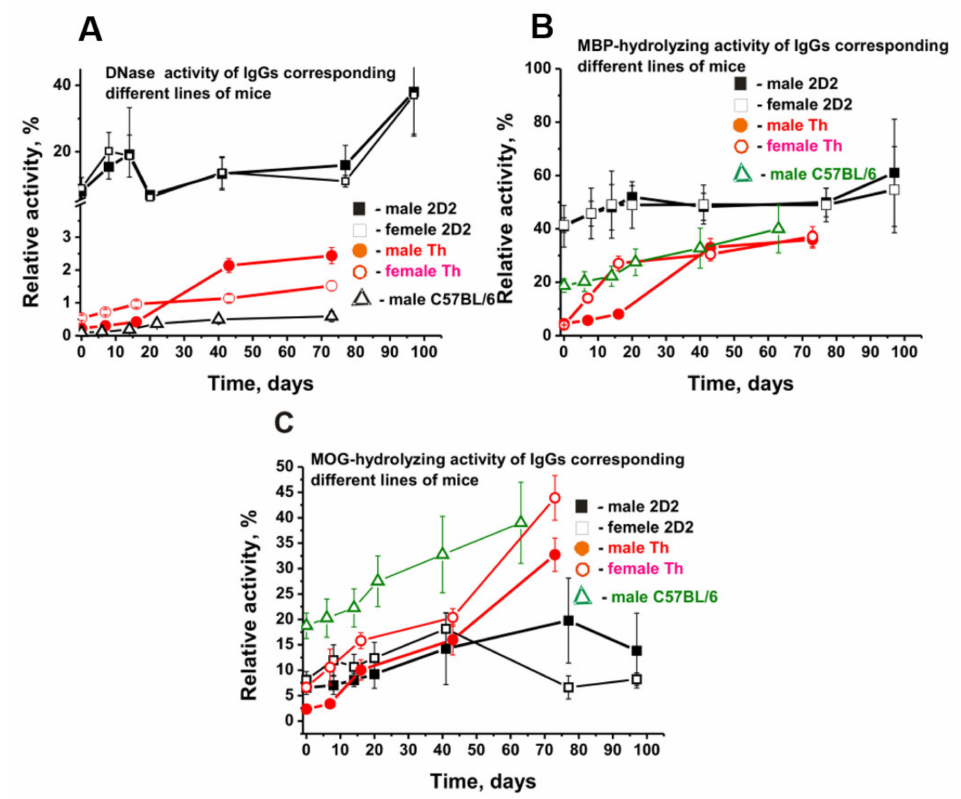
Figure 9. Time-related changes in the IgGs relative activities in the hydrolysis of DNA, MBP, and MOG ( A – C ). Dependencies corresponding to 2D2 (black symbols), Th (red signs), and C57BL/6 (green symbols) males and females are marked in the Figure. For comparison, the data for C57BL/6 [34–37] and Th [38,39] mice were taken from our earlier published articles. The duration of the experiment and the time of blood sampling for different strains of mice were